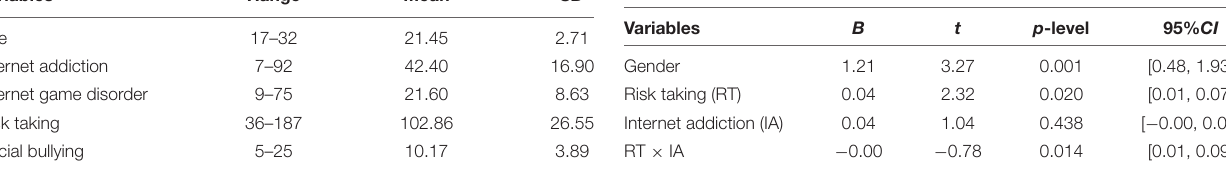
TABLE 4 | Hayes PROCESS macro results for risk taking predicting social bullying with internet addiction as